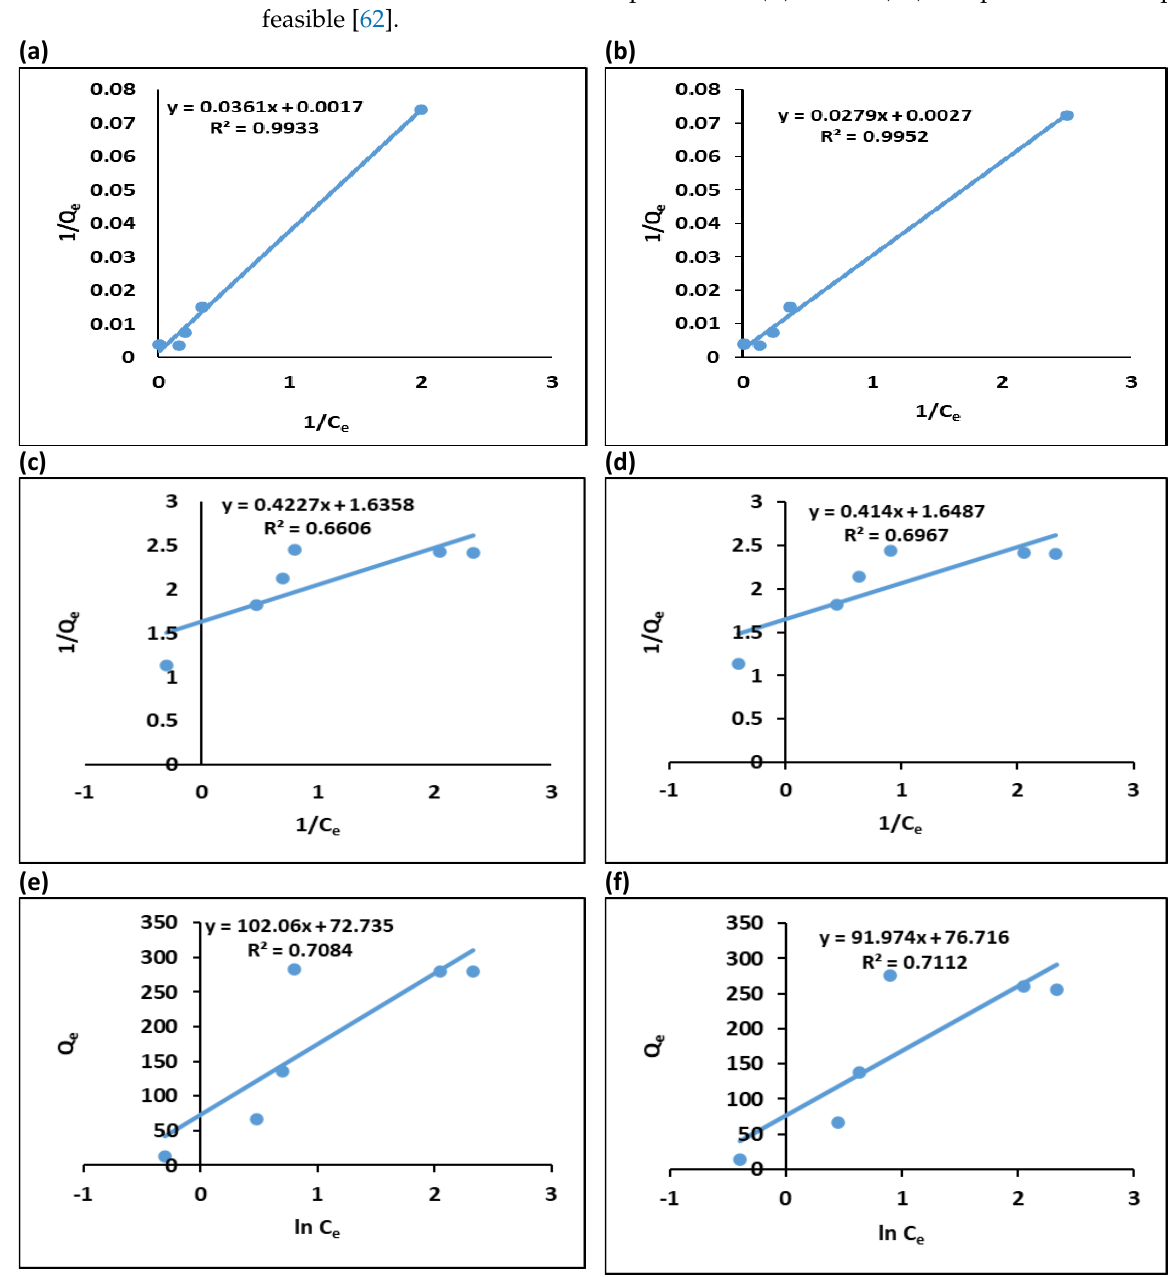
Figure 7. The equilibrium isotherm trends for adsorption of Pb and Cr on to GO-COOH; ( a ) = Langmuir for Pb (II), ( b ) = Langmuir for Cr (VI)), ( c ) = Freundlich for Pb (II) and ( d ) = Freundlich for Cr (VI), ( e ) = Temkin for Pb (II) and ( f ) = Temkin for Cr (VI). Table 1. Adsorption isotherm models parameters.